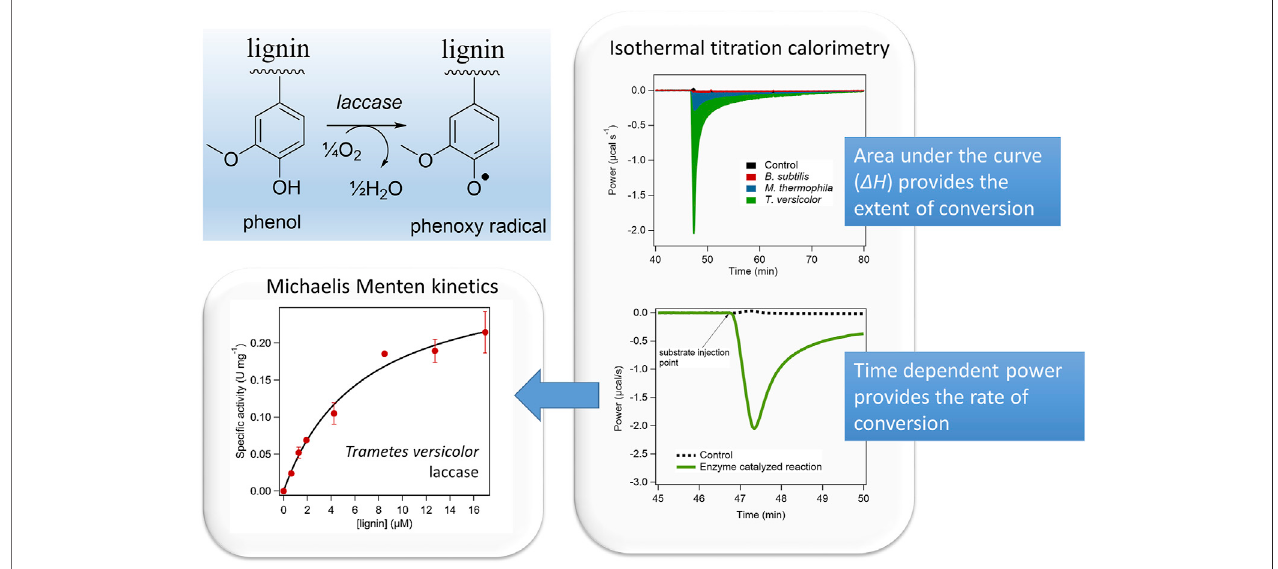
FIGURE 1 | Isothermal titration calorimetry was used to assess the conversion of lignin by three different laccases. Isothermal Titration Calorimetry provides the molarenthalpyofthereaction,whichre fl ectstheextentofconversionandthetimedependentpowertrace,whichre fl ectstherateofthereaction.Largedifferencesinthe extent and kinetics of lignin conversion among the different bacterial and fungal laccases were found. Reprinted with permission from (Islam et al., 2022).